Question: From the figure, is the trend upward or downward?
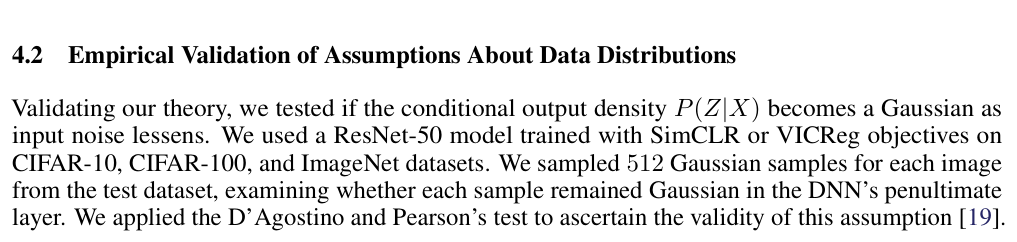
Answer: increasing